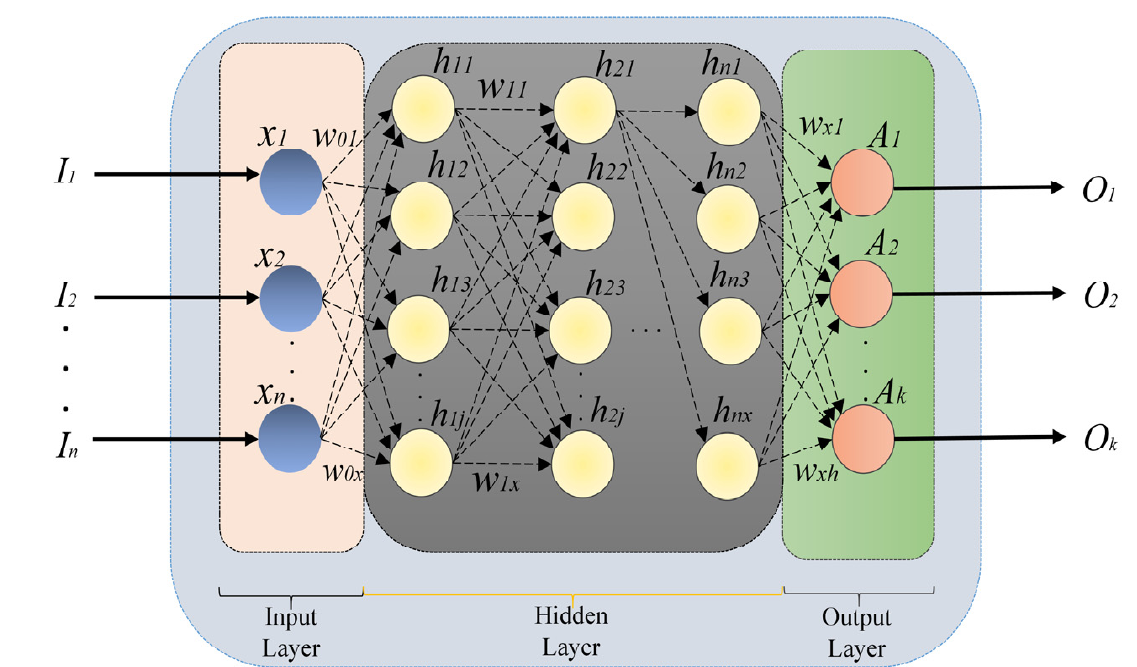
Figure 6. Typical Deep Neural Network scheme.